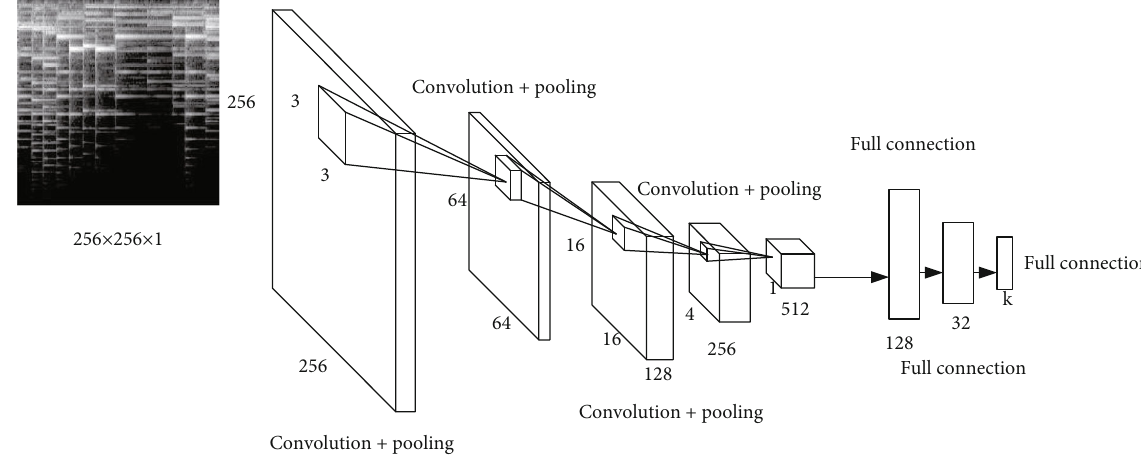
Figure 3: CNN model structure for music potential factor prediction. Table 1: Parameters of the CNN